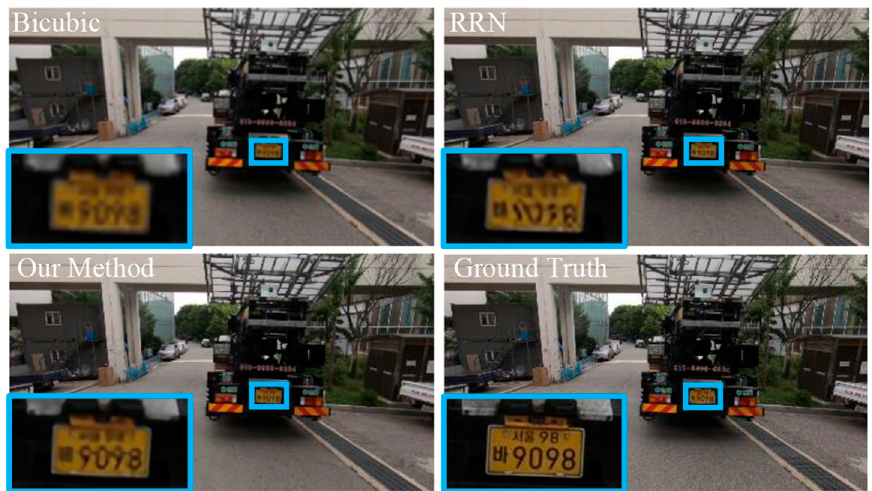
Figure 1. Visual comparison with one of the state-of-the-art methods Recurrent Residual network (RRN). The numbers and words of our methods in zoomed area are more clear (The Korean on the license plate in the figure are symobles for vehicle classification, having no explicit meanings.)